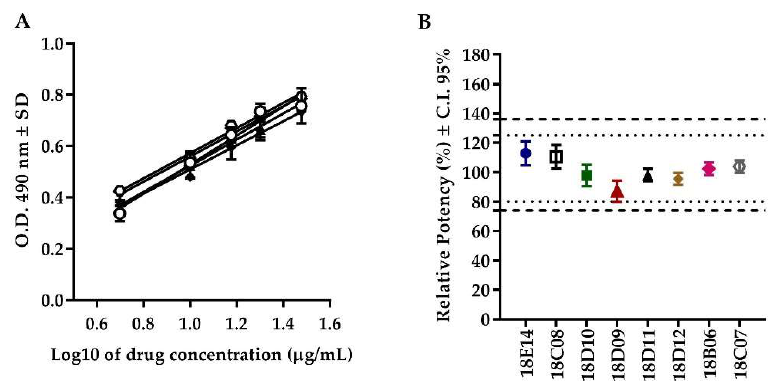
Figure 4. Consistency of the potency among batches of Transferon ® . ( A ) Dose–response curves of different batches of Transferon ® . ( B ) Relative potency of eight batches of Transferon ® with confidence intervals (C.I.) at 95% ( n = 3).